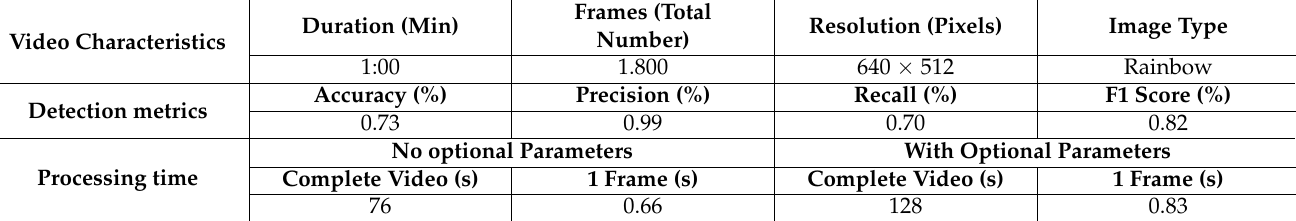
Table 6. Characteristics of the video made in Teresa and the fire detection results obtained by applying the algorithm on the video. Video